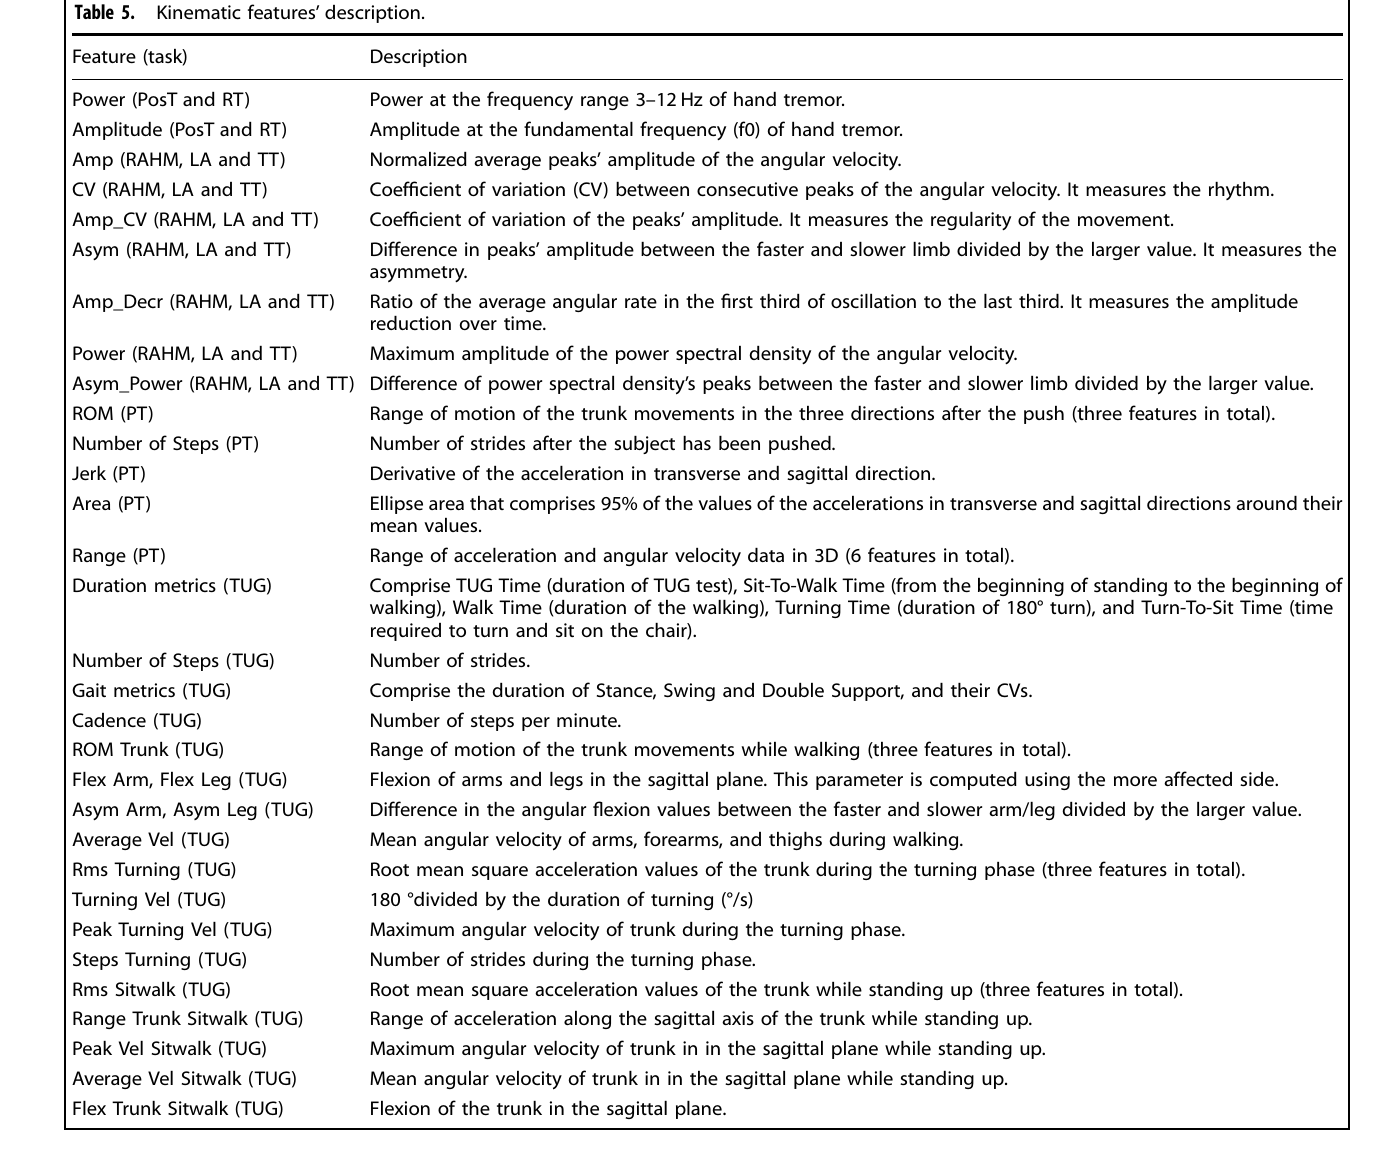
Table 5. Kinematic features ’